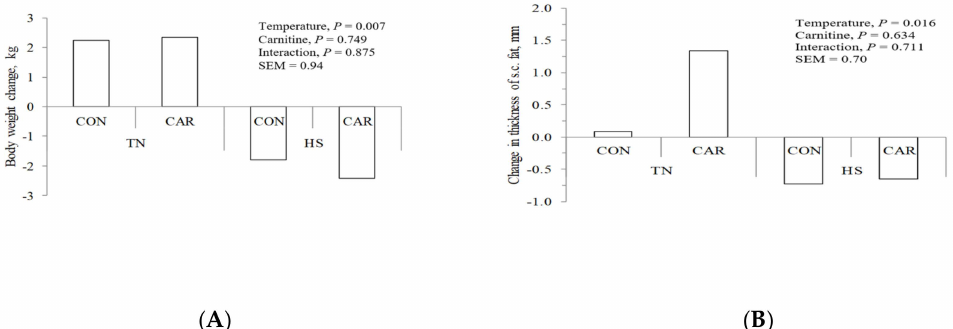
Figure 1. Changes in body weight (A) and subcutaneous fat thickness (B), measured as the di ff erence between values at the start and the end of each experimental period in dairy goats under thermo-neutral (TN) or heat stress (HS) conditions. In each ambient temperature, goats were fed a control diet (CON) or supplemented with 5 g CAR containing 1 g pure